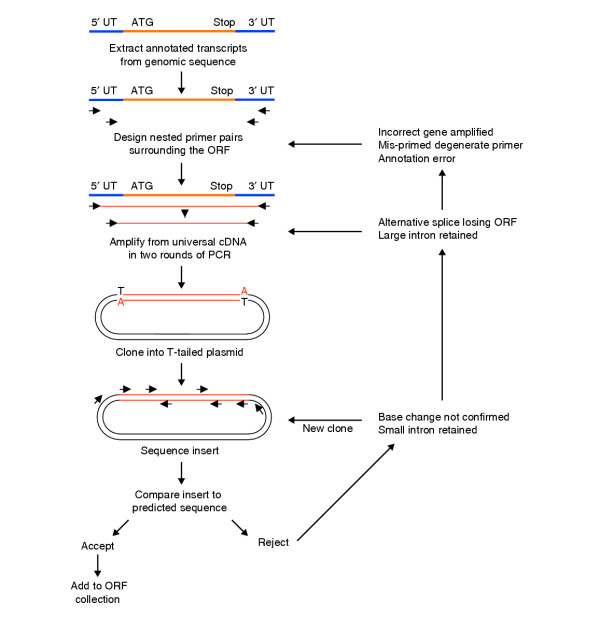
Summary of the ORF cloning method.